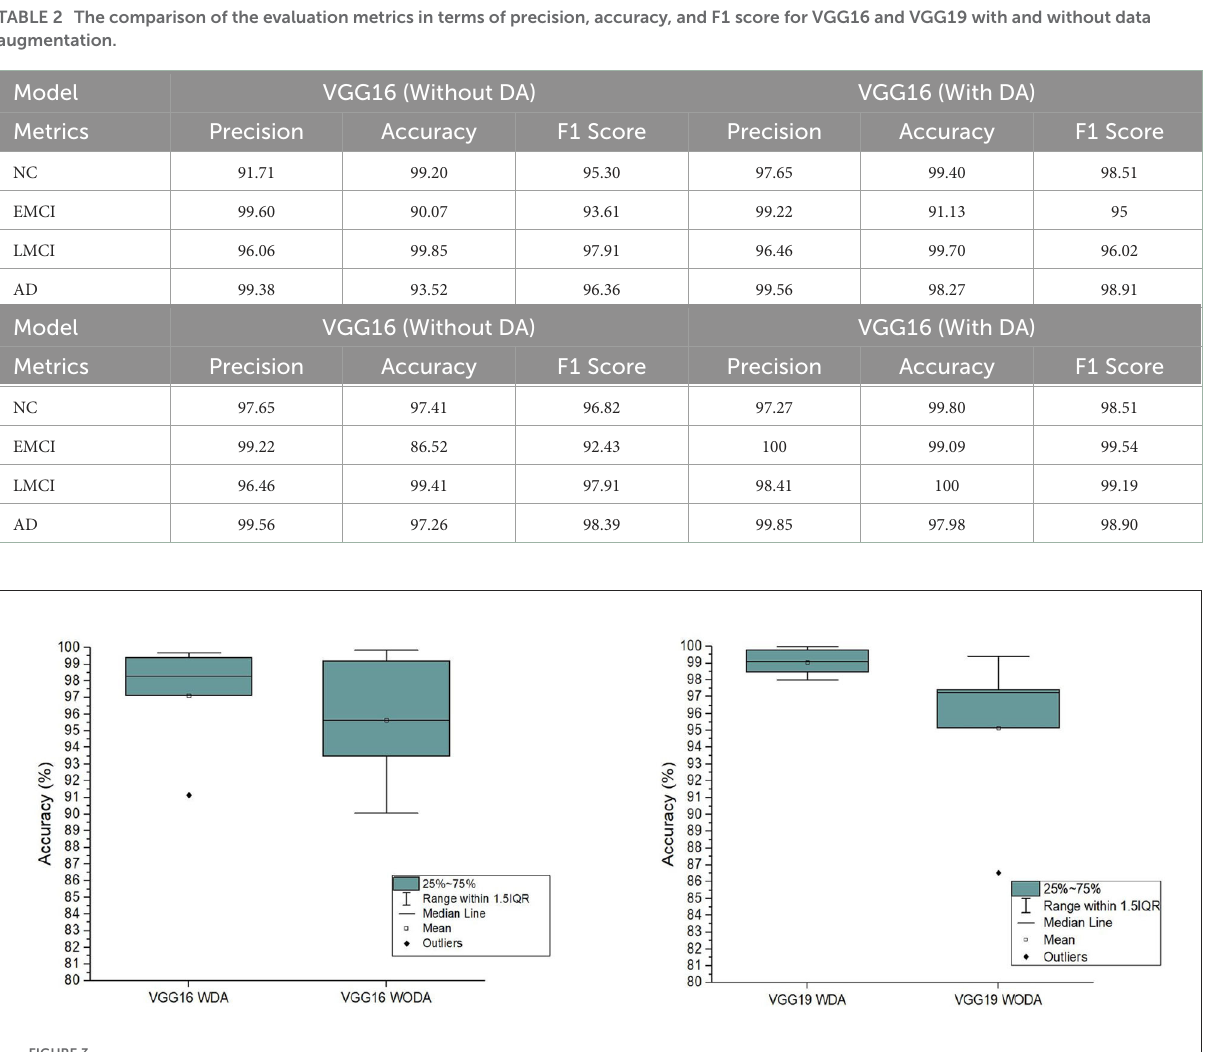
FIGURE3 The comparison of the accuracy of the proposed frameworks with data augmentation (WDA) and without data augmentation